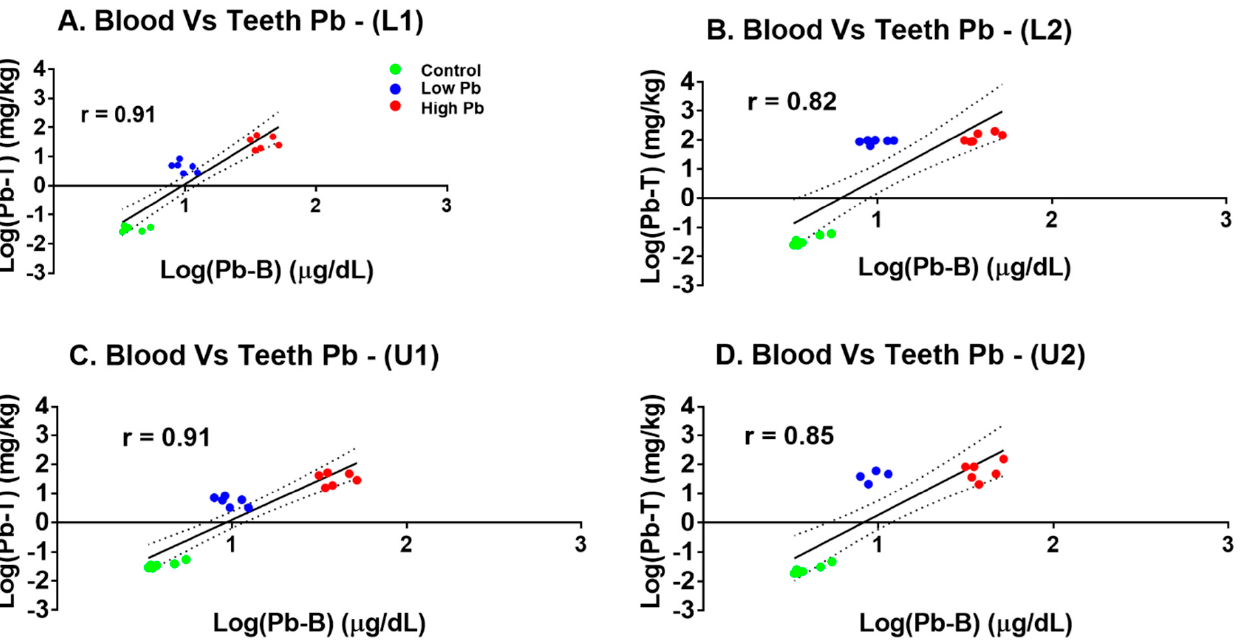
Figure 4. Pearson’s correlations showing the relationship between log-transformed Pb-B and Pb-T crown and root of the lower and upper incisors in the laboratory Pb-exposed Sprague Dawley rats. ( A ) lower incisor (L1) Pb-B versus Pb-T ( r = 0.91, p < 0.01); ( B ) lower incisor (L2) Pb-B versus Pb-T ( r = 0.82, p < 0.01); ( C ) upper incisor (U1) Pb-B versus Pb-T ( r = 0.91, p < 0.01) and ( D ) upper incisor (U2) Pb-B Vs Pb-T ( r = 0.85, p < 0.01).